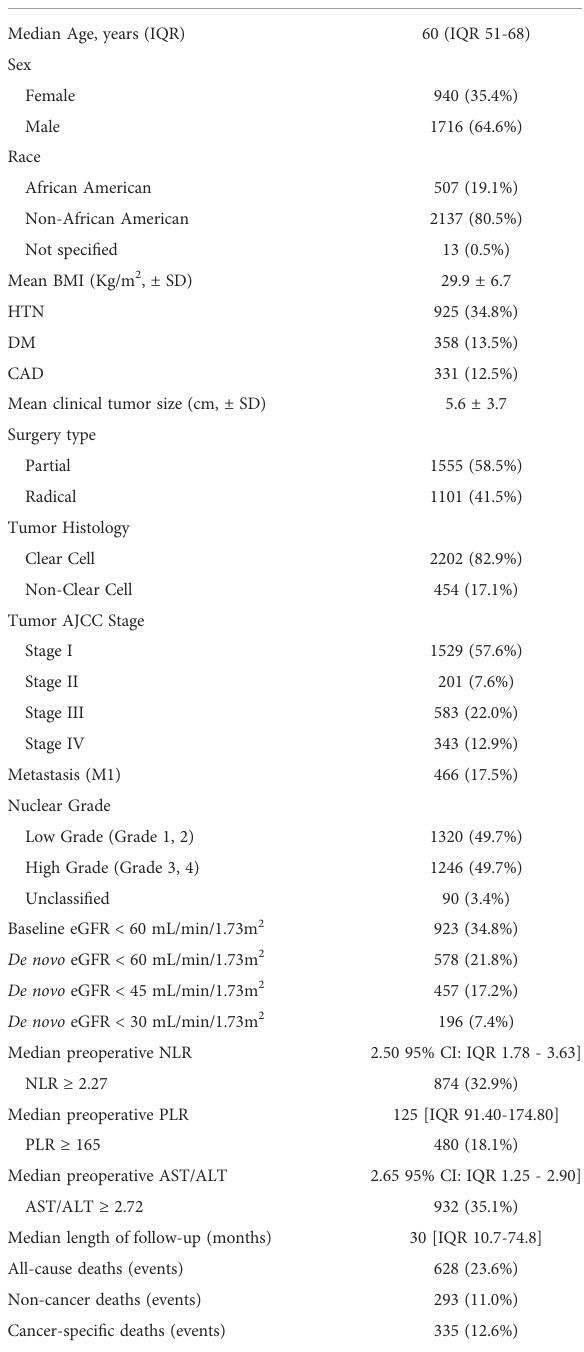
TABLE 1 Patient demographics and operative